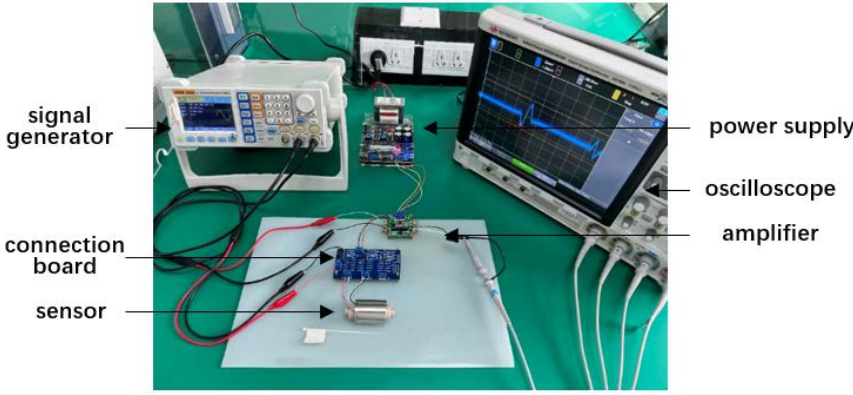
Figure 8. Physical map of the test platform.